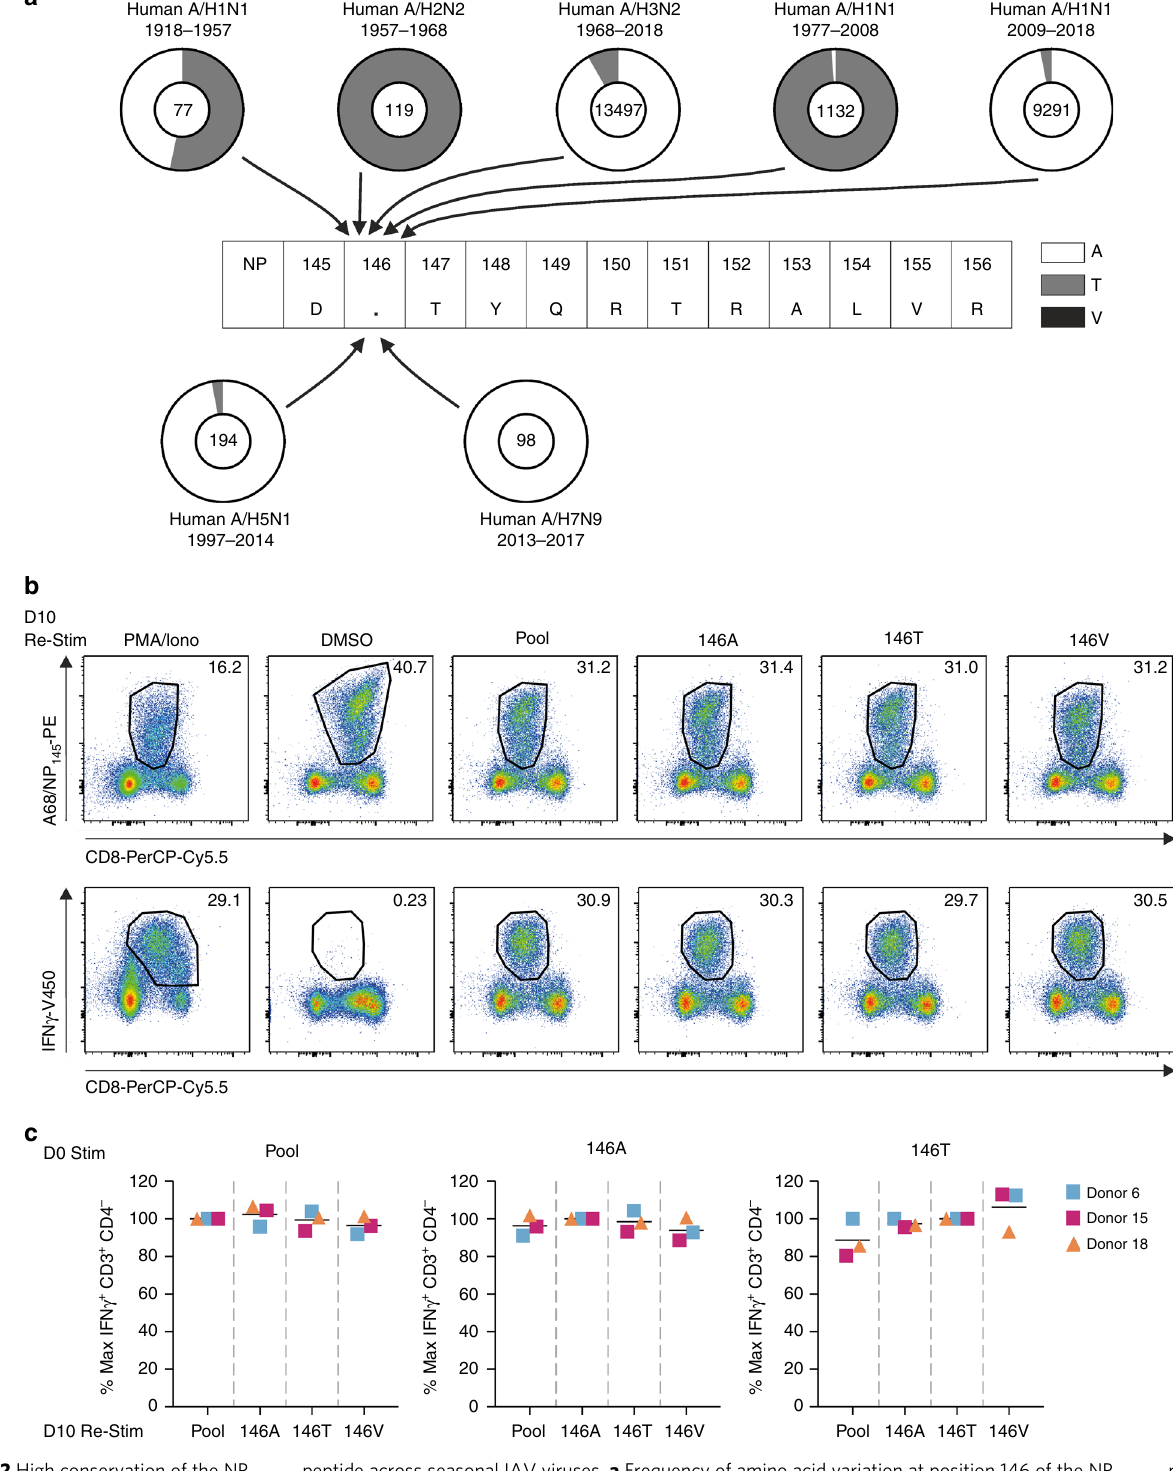
Fig. 2 High conservation of the NP 145-156 peptide across seasonal IAV viruses. a Frequency of amino acid variation at position 146 of the NP 145 – 156 peptide. Pie charts represent frequency of alanine (A; white), threonine (T; gray) and valine (B, black) at position 146. Total number of analyzed sequences are indicated in the pie charts: A/H1N1 (1918 – 1957 n = 77, 1977 – 2008 n = 1132, 2009 – 2018 n = 9291), A/H2N2 (1957 – 1968 n = 119), and A/H3N2 (1986 – 2018 n = 13,497), avian A/H5N1 (1997 – 2014 n = 194) and A/H7N9 (2013 – 2017 n = 98). b Representative FACS panels of A68/NP 145 -speci fi c CD8 + T cells expanded by 146A peptide stimulation on day 0, followed by restimulation at day 10 with cognate or variant NP 145 peptides. Day 10 restimulation with PMA/Ionomycin was included as a positive control and DMSO as a negative control. c Percentage of maximum IFN γ + CD3 + CD4 − T cells following secondary stimulation. Maximum IFN γ is de fi ned as IFN γ + CD3 + CD4 − T cells following cognate restimulation with peptide pool (pool), D A TYQRTRALVR (146A), D T TYQRTRALVR (146T) or D V TYQRTRALVR (146V) peptides, respectively. Pool included 146A, 146T, and 146V variants. The bar indicates the mean response of three donors ( n =